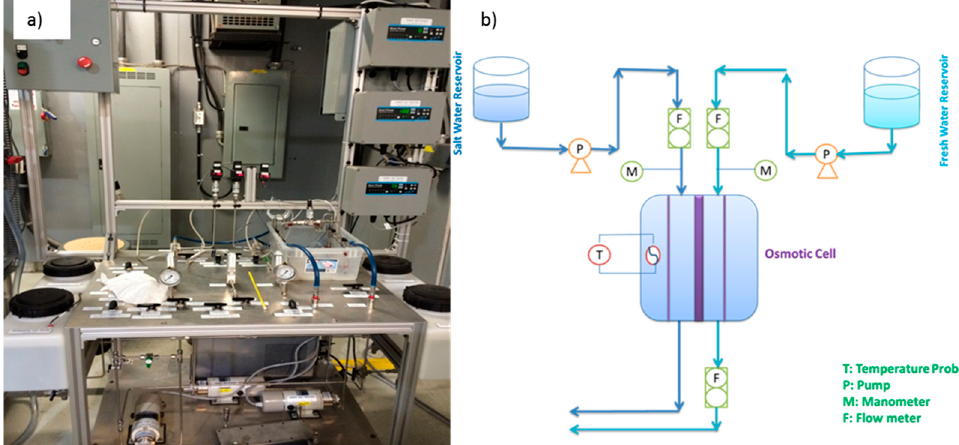
Figure 2. Hollow Fiber Membrane Module.